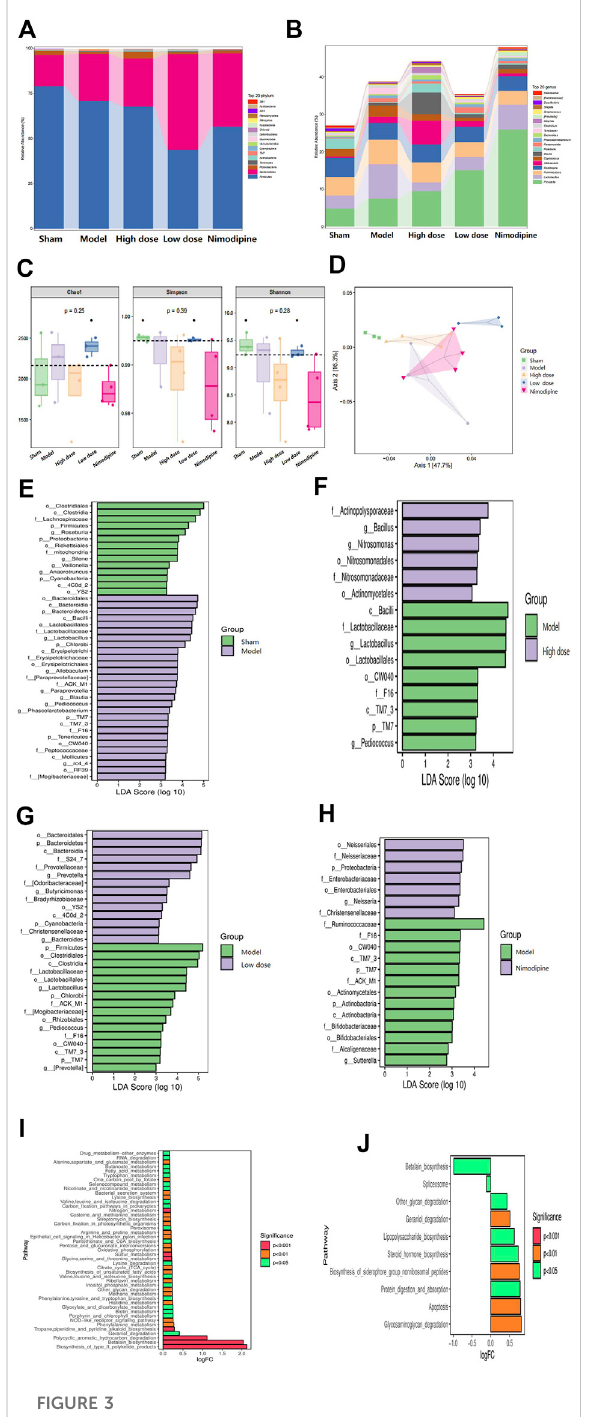
FIGURE 3 ZHTC improves intestinal fl ora imbalance in MCAO